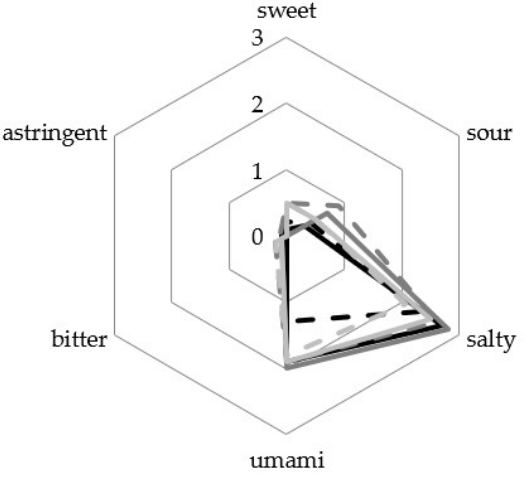
Figure 4. Sensory analysis of the taste of resulting seasoning sauces. Values of moromi with lupine seeds is shown as black lines (ML1) and dashed lines (ML2), with wheat as dark grey lines (MW1) and dashed lines (MW2), and with buckwheat as light grey lines (MB1) and dashed lines (MB2). Data are presented in a 6-point hedonic scale.